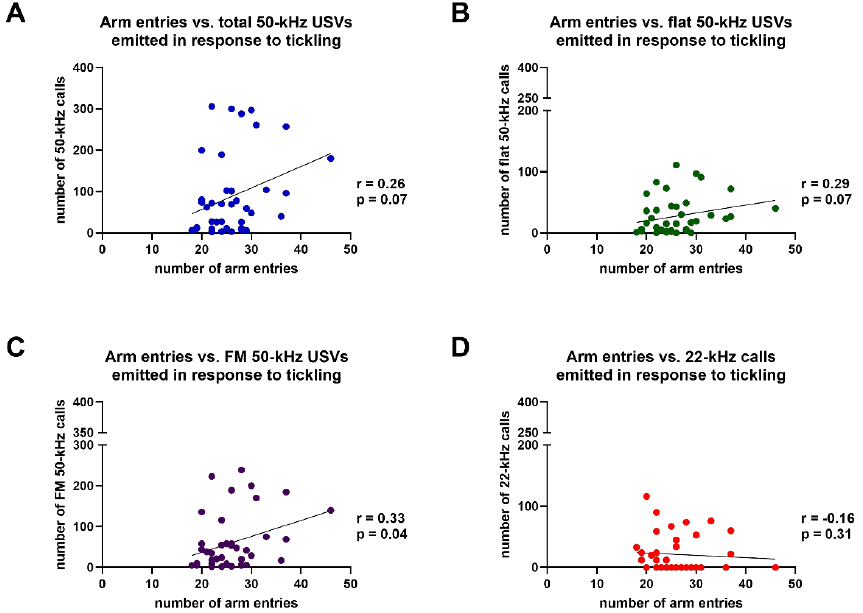
Figure 10. Results of Spearman’s correlation test between the numbers of entries in the arms of the Y maze and the numbers of total 50-kHz ultrasonic vocalizations ( A ), flat 50-kHz ultrasonic vocali- zations ( B ), frequency modulated 50-kHz ultrasonic vocalizations ( C ) or 22-kHz ultrasonic vocali- zations ( D ) emitted in response to tickling. FM = frequency modulated; USVs = ultrasonic vocaliza- tions. n = 40.